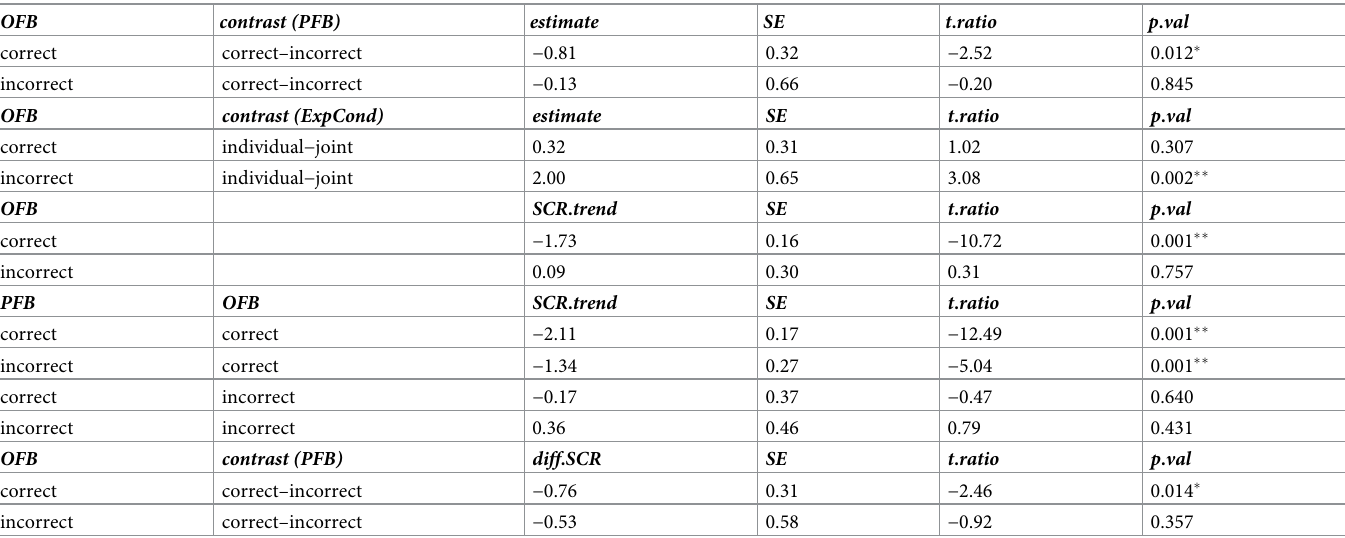
Table 7. Summaries of post-hoc test for gain- and loss-related P300.